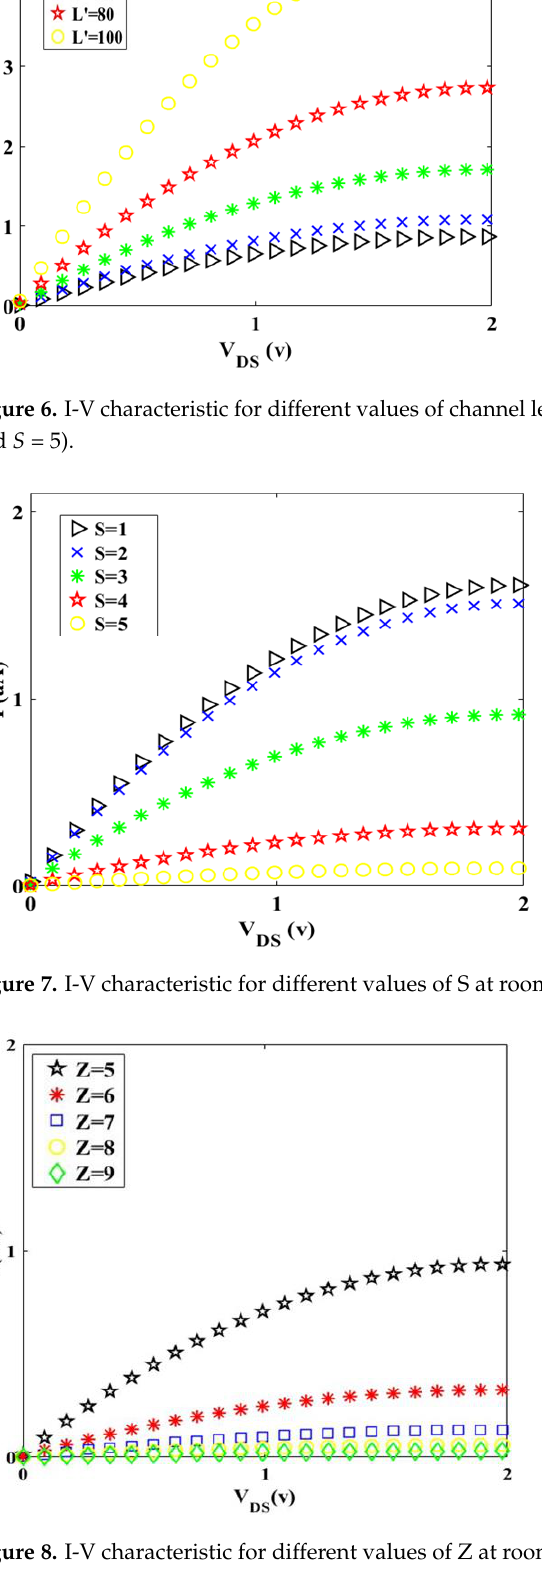
Figure 8. I-V characteristic for different values of Z at room temperature (S = 10). Hence, the drain current decreases. In comparison with Figure 7, in Figure 8, it can be said that even by the selection of larger Z (inset values of Figure 8) compared to amounts of S (inset values of Figure 7), the drain current is more for S , which means that the effect of S is higher than Z on Schottky transistor performance. This is due to the me- chanical properties of twisted graphene structure, which means that if the twists ( S ) are